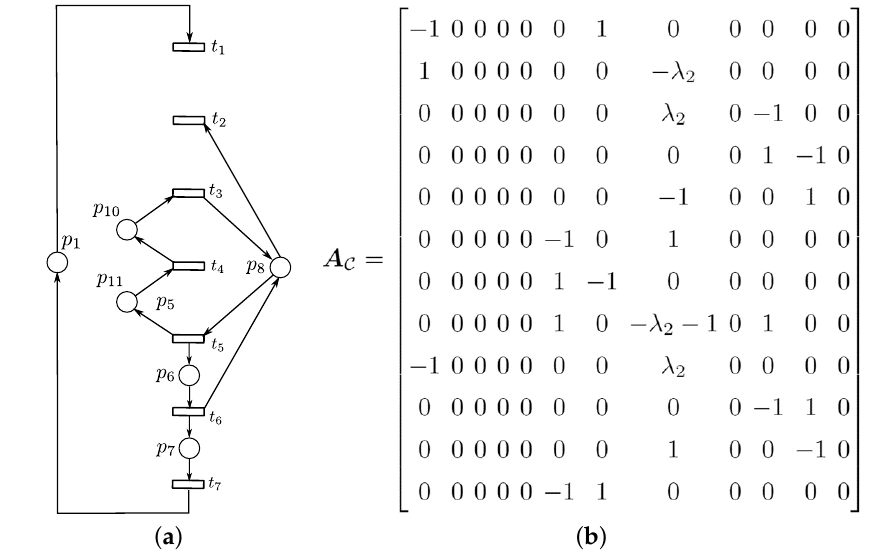
Figure 5. Subnet of configuration C 1,8,10,11,8,6,7 of the TCPN model of Figure 1b and the dynamic matrix of its associated operation mode. ( a ) Subnet. ( b ) Dynamic